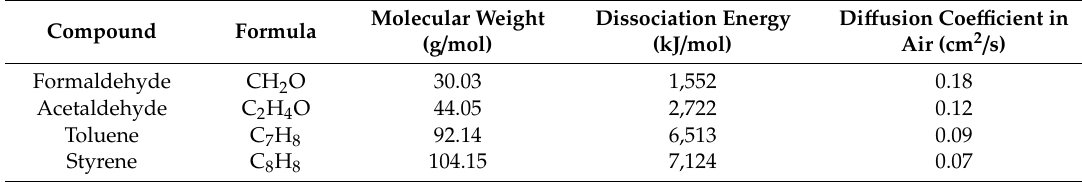
Table 2. Comparison of physical / chemical properties of di ff erent VOCs [14].